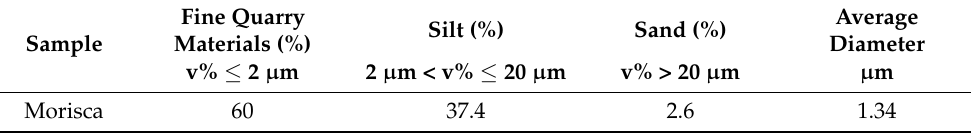
Table 3. Granulometric composition in the percentage of the morisca sample.